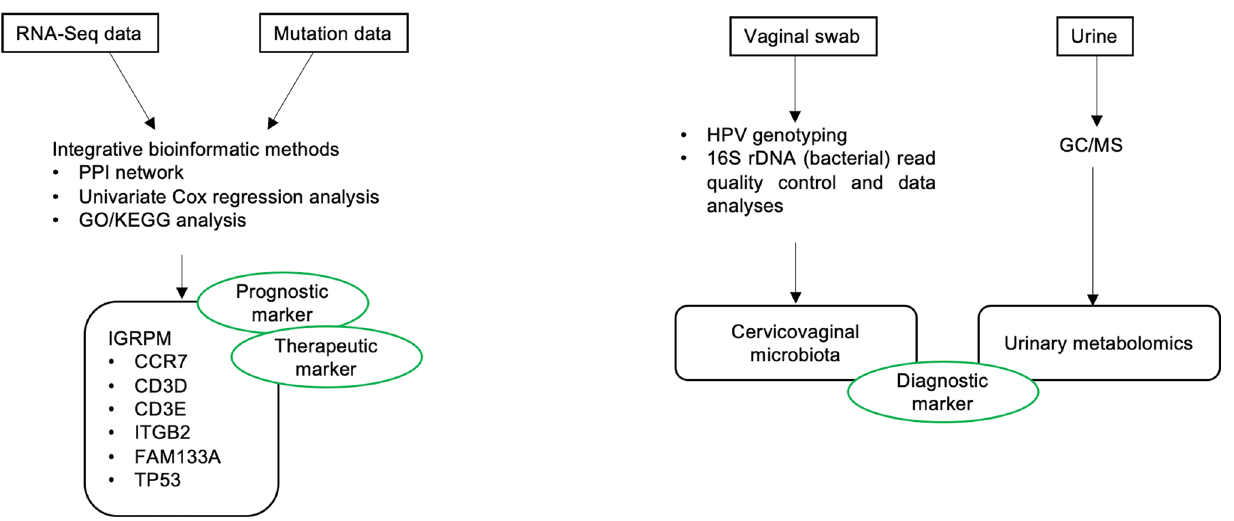
Fig. 3 Potential biomarkers identified by the integrative multi-omics